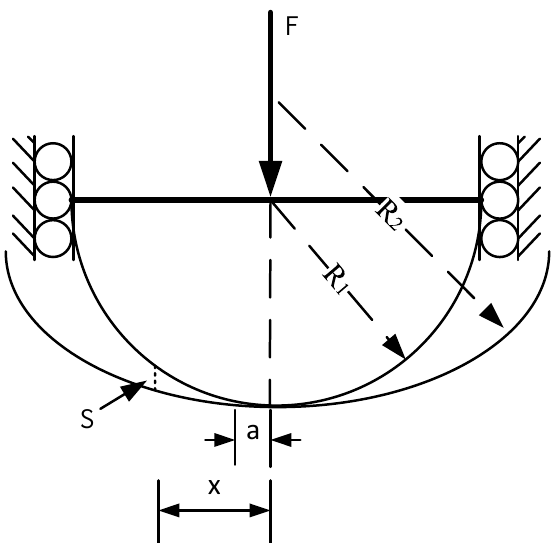
Figure 3. Construction process ( a ) main arch construction; ( b ) cable tension; ( c ) rotating process; ( d ) closure of main arch; ( e ) pier and deck construction.